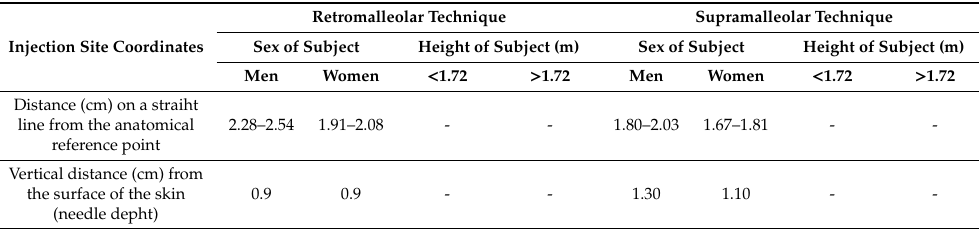
Table 1. Injection site coordinates for both techniques obtained from prior ultrasound scans of the tibial nerve.